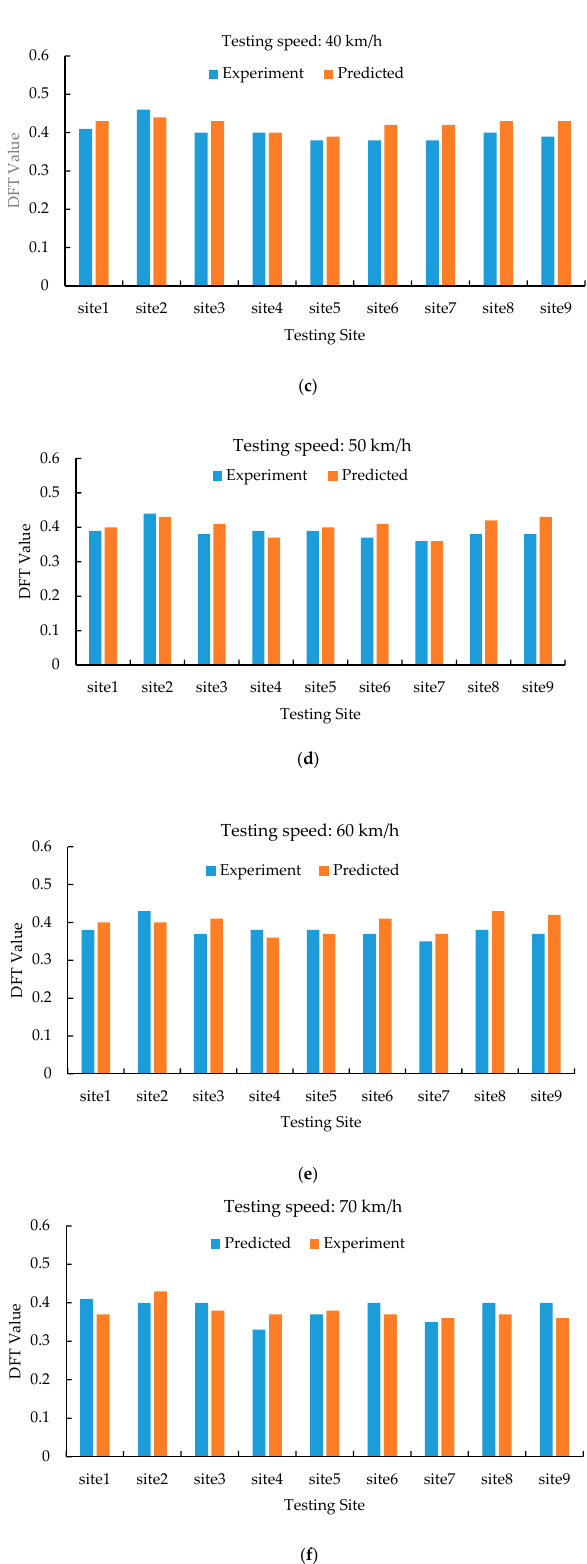
Figure 11. Model validation and comparisons: ( a ) Predicted results vs experimental data at the speed of 20 km/h; ( b ) Predicted results vs experimental data at the speed of 30 km/h; ( c ) Predicted results vs experimental data at the speed of 40 km/h; ( d ) Predicted results vs experimental data at the speed of 50 km/h; ( e ) Predicted results vs experimental data at the speed of 60 km/h; ( f ) Predicted results vs experimental data at the speed of 70 km/h.